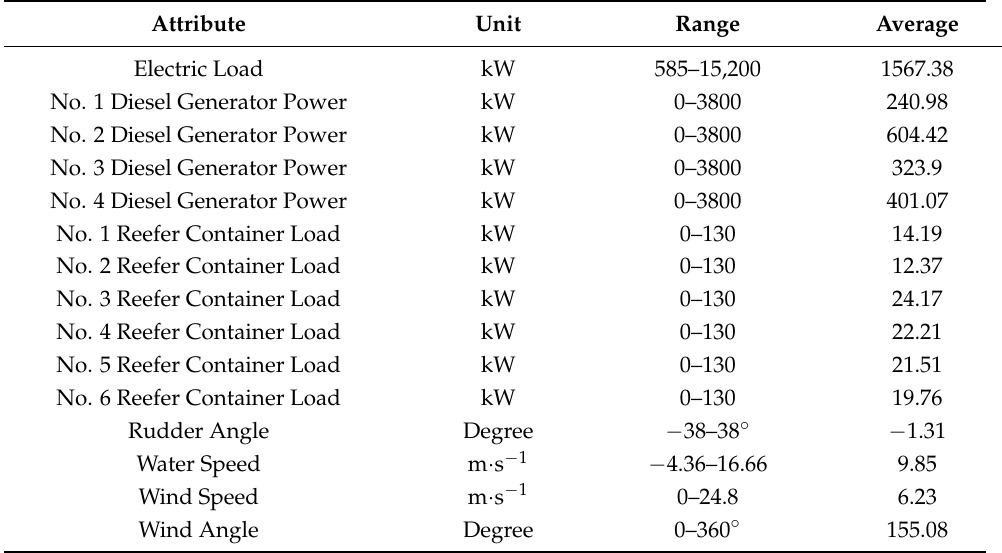
Table 1. List and features of the selected